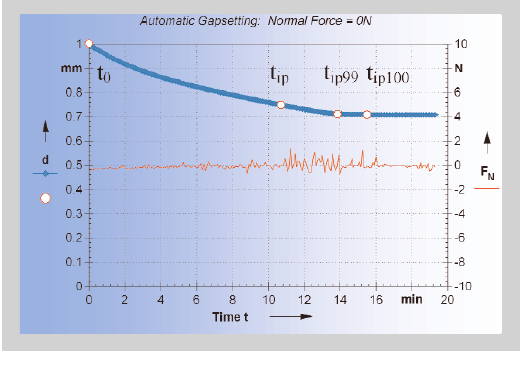
Figure 6 (left): Normal force controlled gap setting during the dewatering process. Figure 7 (right): Immobilization of a paper